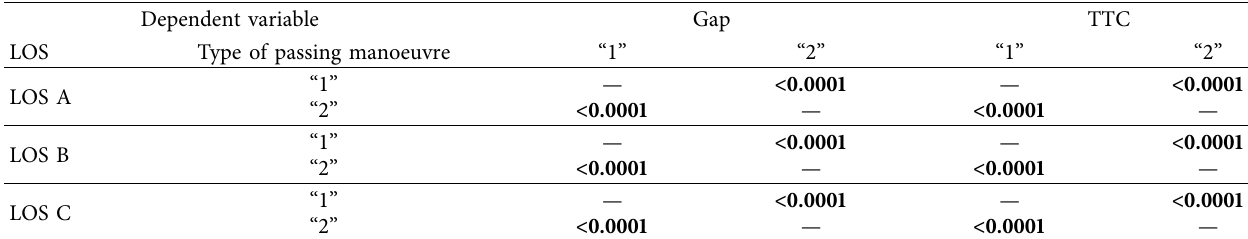
Boldface indicates statistically significant values with a 5% level of